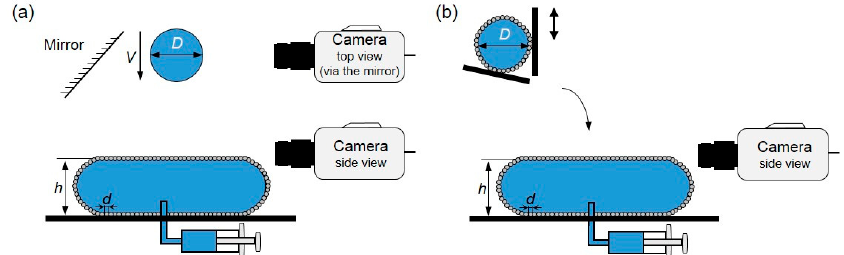
Figure 16. Sketch of impacts between armored interfaces recorded by a high-speed camera. ( a ) Single armor experimental set-up: a bare water droplet impacts on a water puddle armored with particles of diameter d . Two synchronized high-speed cameras record side and top views of the impacts; ( b ) double armor experimental set-up: a liquid marble (LM) impacts on the armored interface of another larger LM.